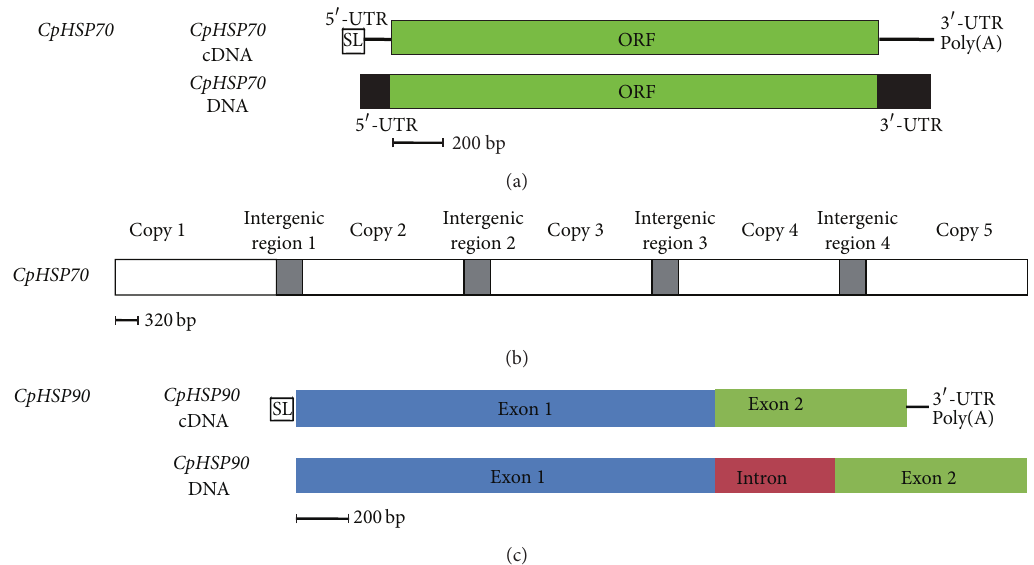
Figure 3: Schematic structures of genomic DNA of CpHSP70 and CpHSP90 . (a) Comparison of DNA and cDNA of CpHSP70 . (b) Predicted genomic DNA structure of the CpHSP70 : the different copies of the CpHSP70 genes are separated by intergenic regions. (c) Comparison of DNA and cDNA of CpHSP90 . One intron (red box) was found in the genomic DNA sequence of CpHSP90